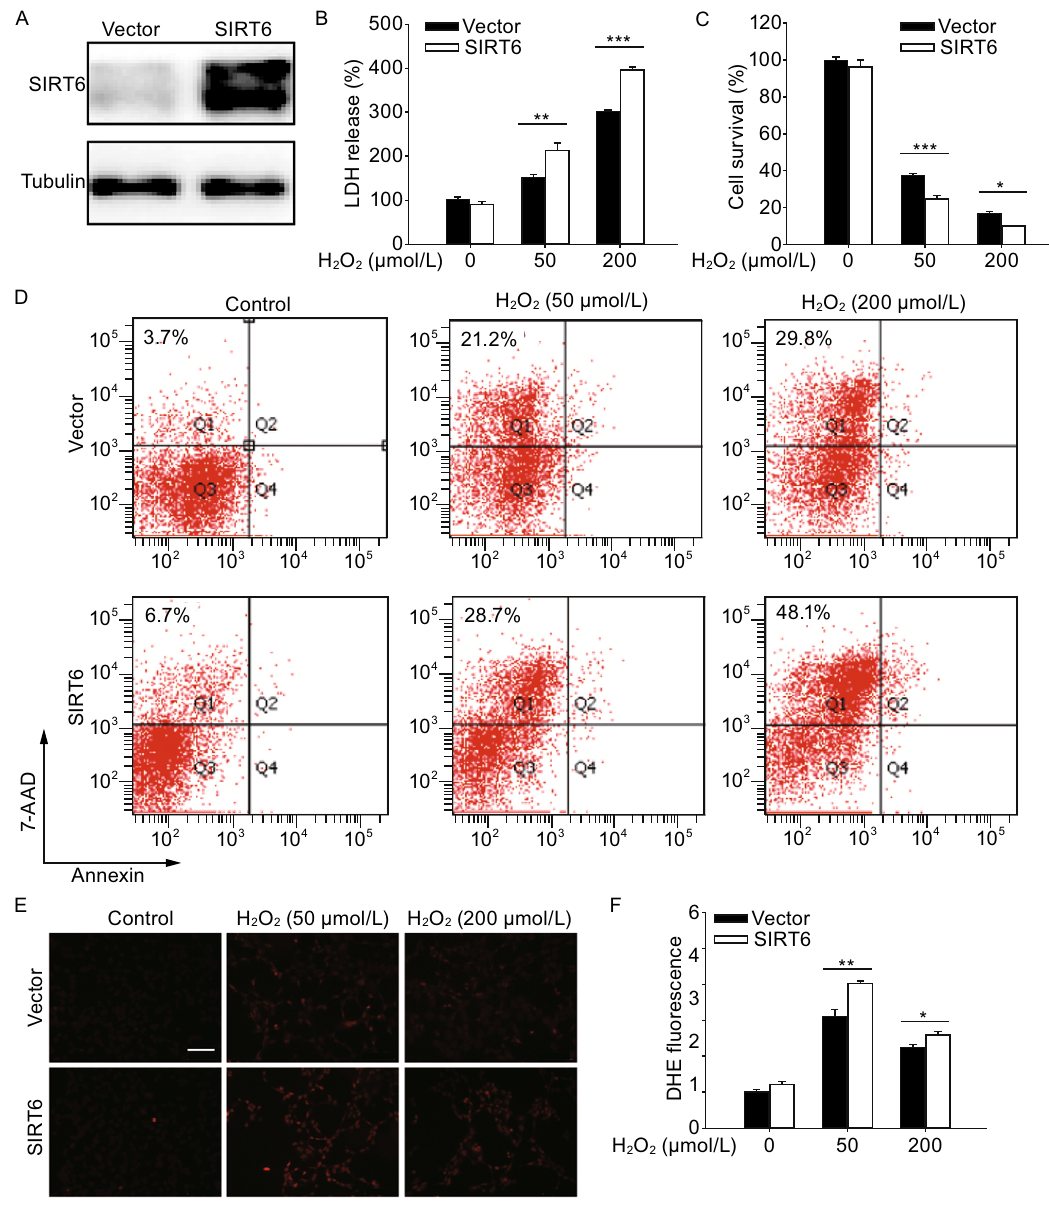
Figure 2. SIRT6 enhances H 2 O 2 -induced cell death and ROS accumulation. (A) Western blot analysis of SH-SY5Y cells stably transfected with vector or SIRT6 lentivirus. (B and C) SH-SY5Y cells were pretreated with H 2 O 2 for 1 h and then cultured for 24 h. Cell death was assessed by LDH release assay and cell viability was assessed by CCK-8 assay. (D) Necrosis and apoptosis were assessed by Annexin V/7-AAD assay. (E and F) SH-SY5Y cells were pretreated with H 2 O 2 for 1 h and then cultured for 6 h. Intracellular ROS levels were visualized by DHE staining and quanti fi ed. Bars represent the mean ± SEM from at least three independent experiments. Scale bar = 100 µm, * P < 0.05; ** P < 0.01; *** P